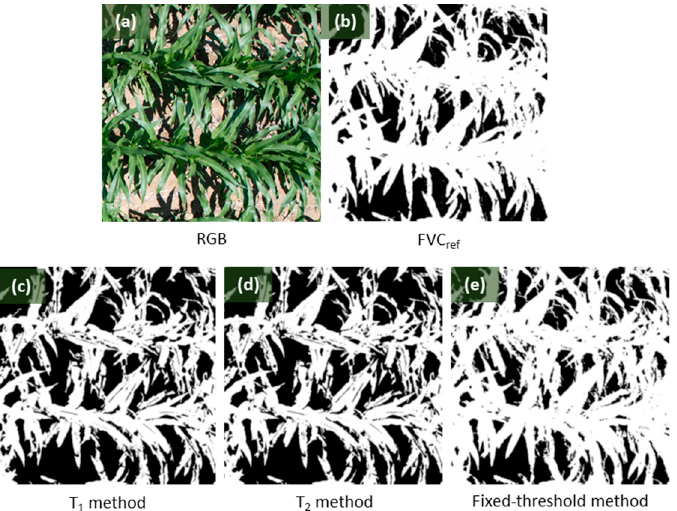
Figure 8. Part of the ( a ) RGB image captured from fully irrigated plots, with FVC ref of 0.67; ( b ) the FVC ref obtained by supervised classification via Environment for Visualizing Images (ENVI); and comparison of FVC maps obtained by using ( c ) T 1 method, ( d ) T 2 method, and ( e ) the fixed-threshold method proposed in this study.